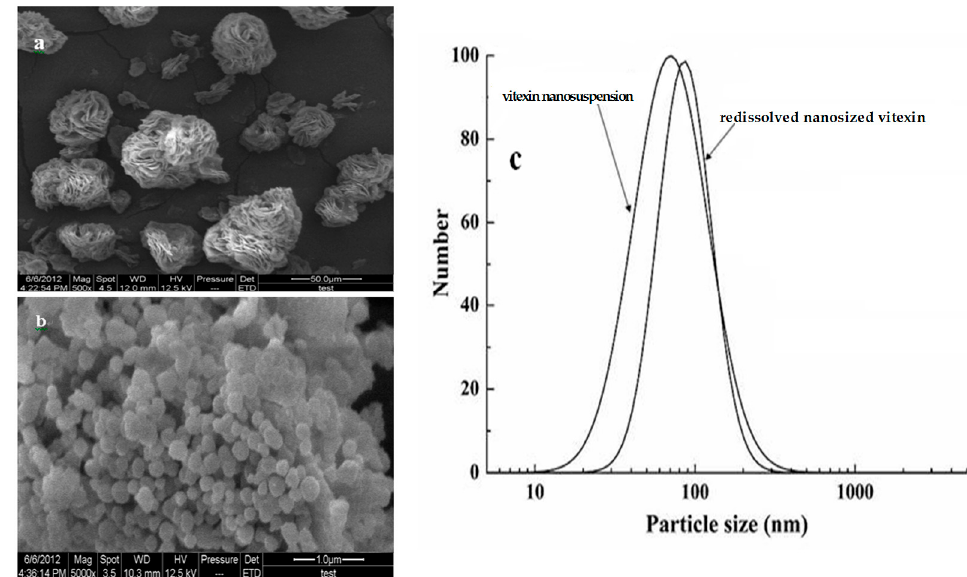
Figure 4. SEM images of ( a ) raw vitexin, ( b ) vitexin nanoparticles, and ( c ) Particle size distribution (PSD) of redissolved vitexin nanoparticles.